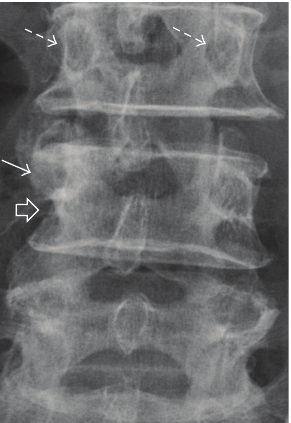
Figure 1: Localised anteroposterior view of lumbosacral radiograph showing erosion of the lateral half of the right L4 pedicle (white arrow), lateral border of the vertebral body (open arrow), and associated bony sclerosis. Note the normal, symmetrical pedicles at L3 (dashed